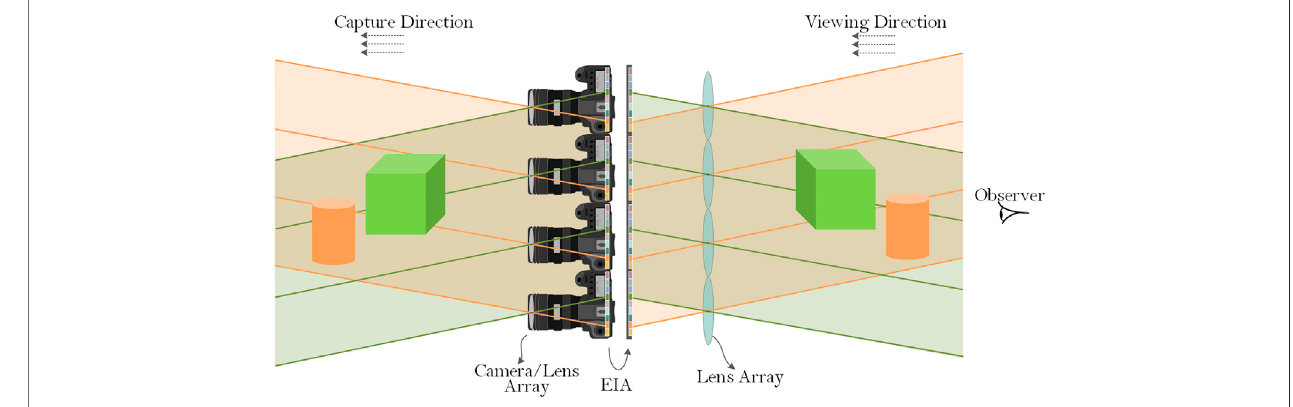
FIGURE 1 | Pseudoscopic issues in integral imaging.